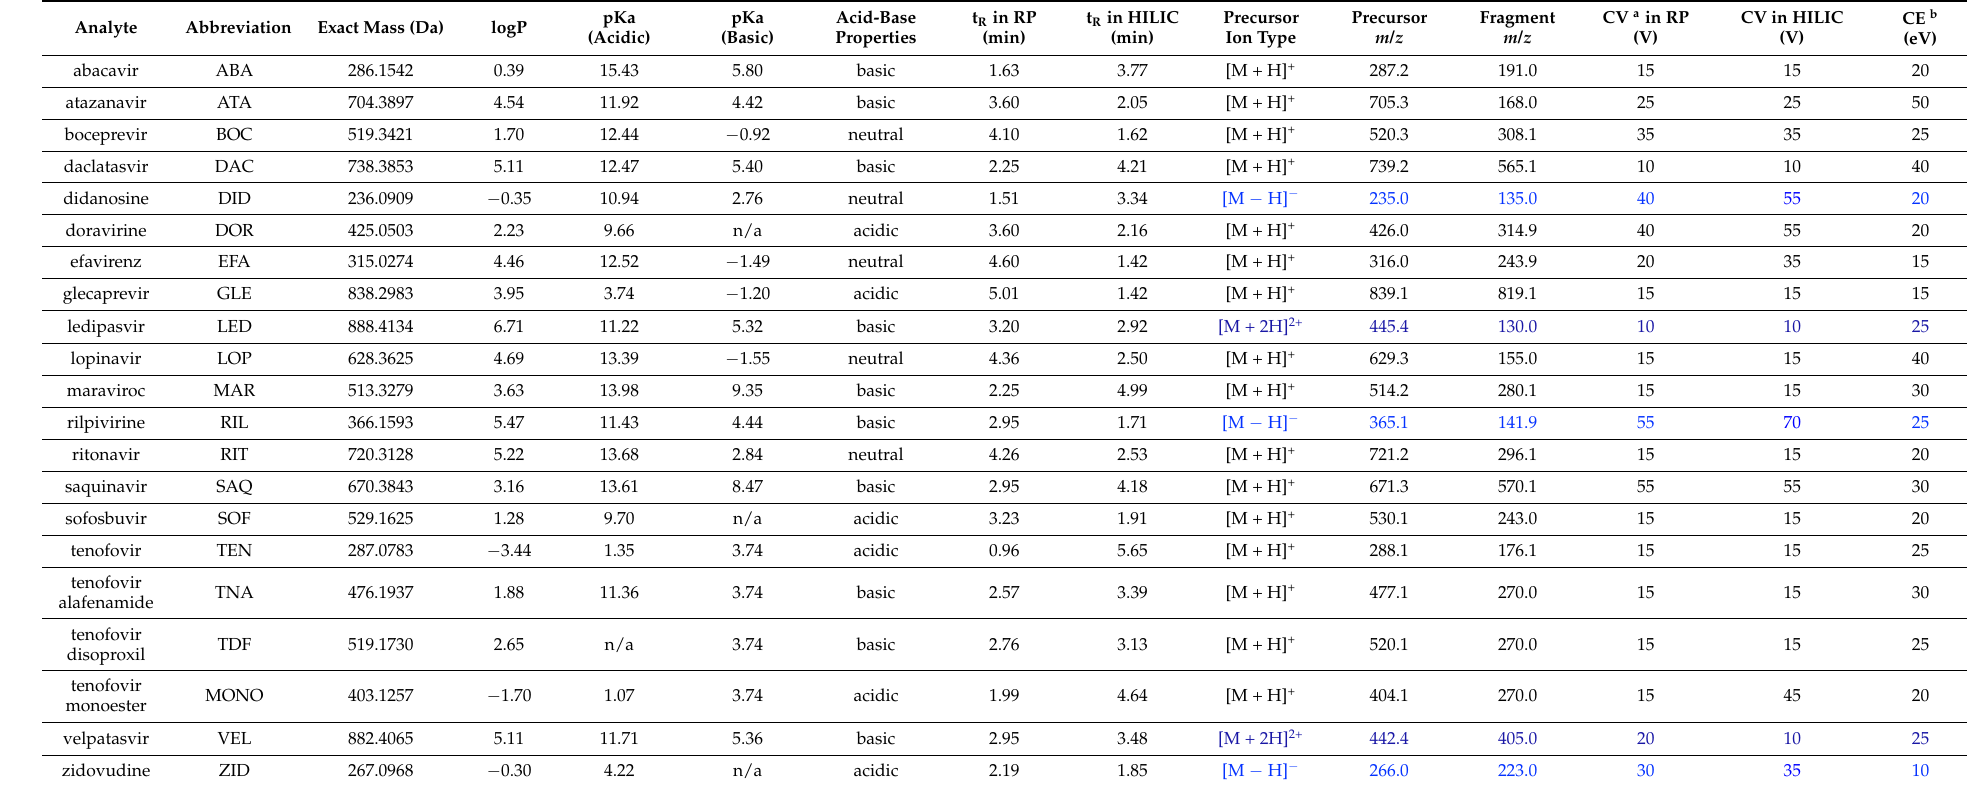
Table 1. Physicochemical properties of antiviral drugs in this study and parameters of optimized SRM